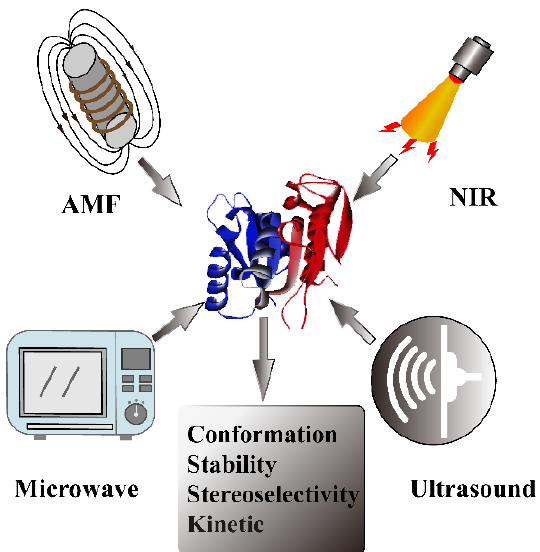
Figure 1. Strategies of real-time enzyme activation including near-infrared, microwave, ultrasound, and alternating magnetic field.